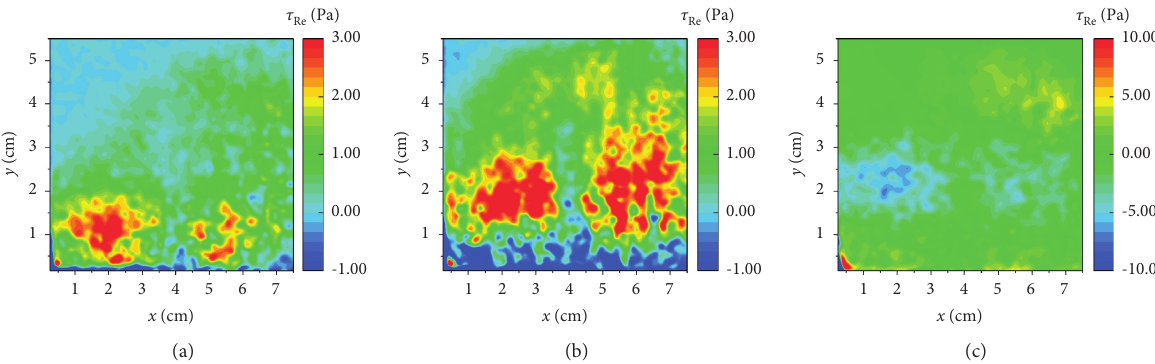
Figure 15: The distribution of Reynolds stress in different working conditions. (a) B25S. (b) B25M. (c) B25L.